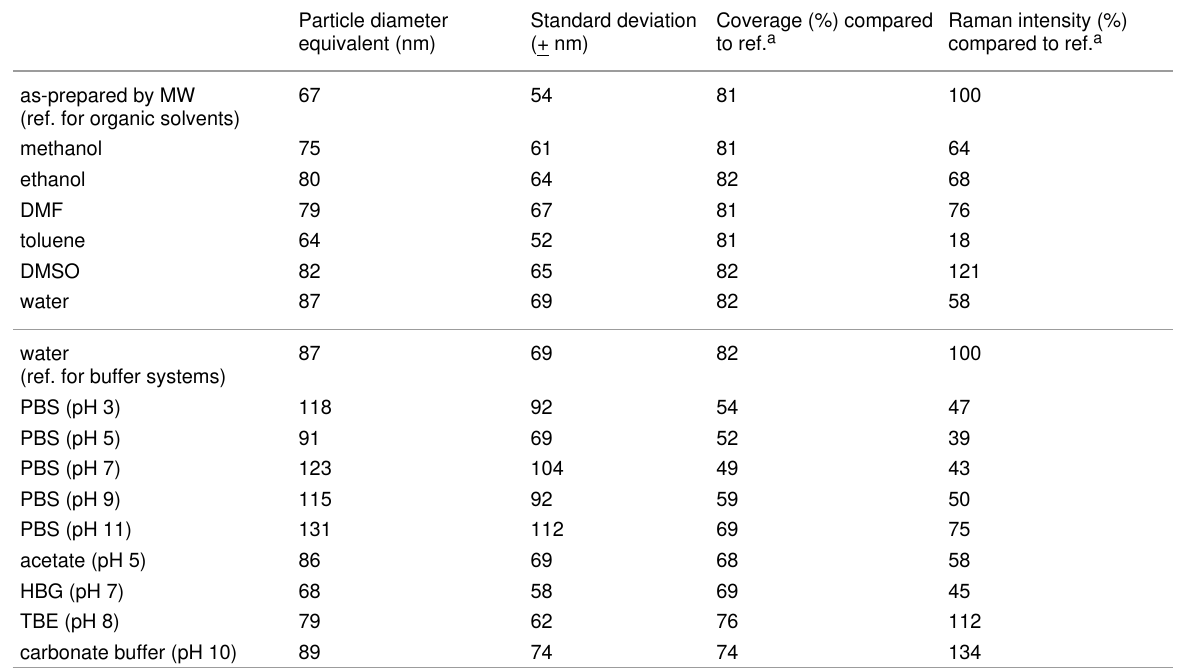
Table 1: Summary of the morphological properties and SERS activities of SERS substrates after treatment with different solvents. Raman intensities are reported relative to the respective reference substrates.